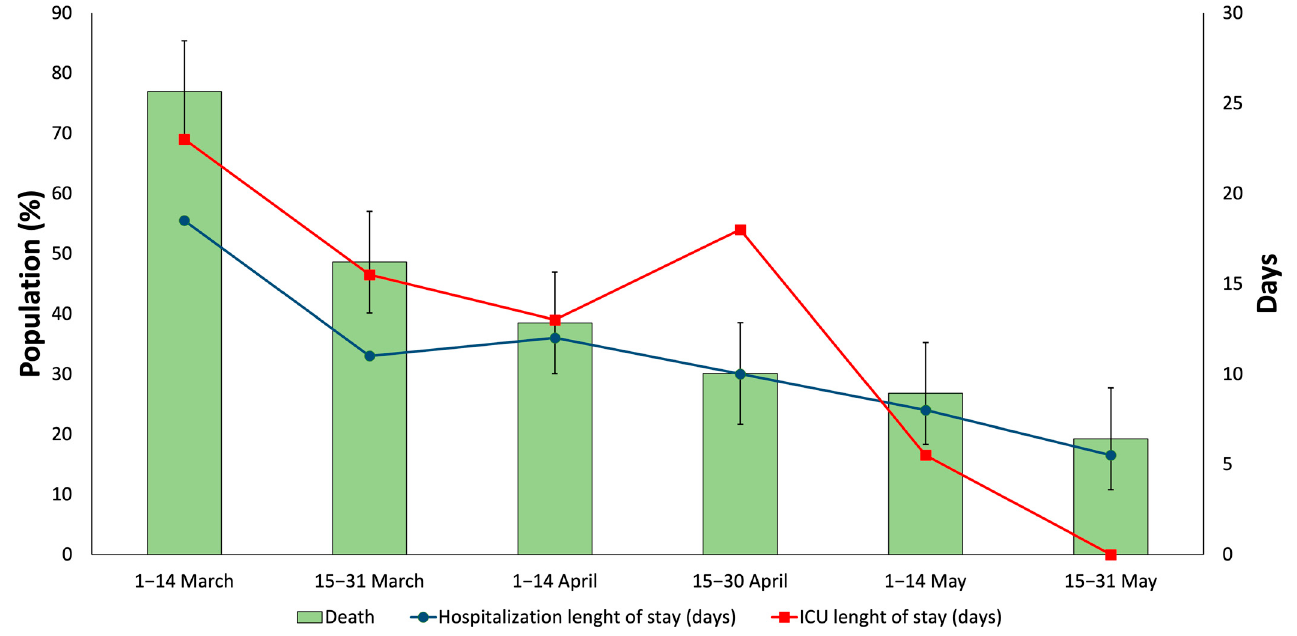
Figure 1. Death and hospital length of stay corresponding to the in-hospital COVID-19 patients with severe acute respiratory syndrome in Castile and Leon (Spain) (1 March–31 May 2020).